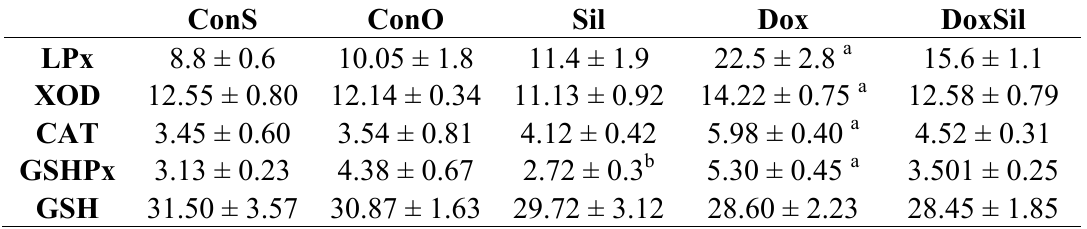
a p < 0.05 compared to ConS, ConO, Sil and DoxSil; b p < 0.05 compared to ConO and Dox; n = 6; mean ± SD. GSH is expressed in nmol/mg of protein, activity of XOD, GSHPx and CAT are expressed in nmol/mg of protein min − 1 . The intensity of lipid peroxidation (LPx) is expressed in nmol malondialdehyde/mg of